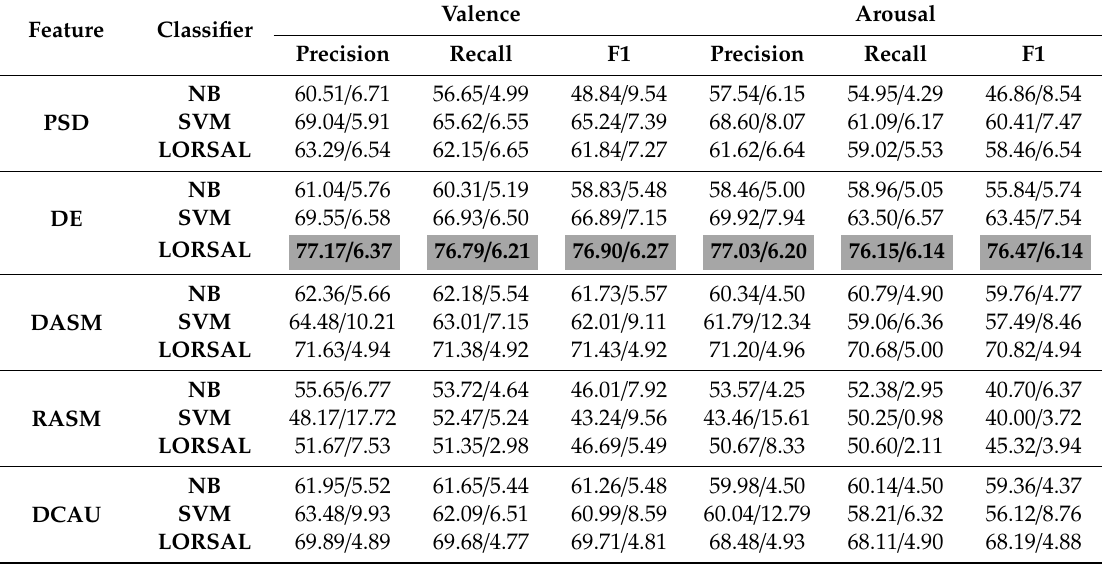
Table 3. The mean metrics and standard deviations (%) of precision, recall, and F1 for the binary classification of LV / HV and LA / HA emotions obtained by the compared classifiers for di ff erent features extracted the total frequency